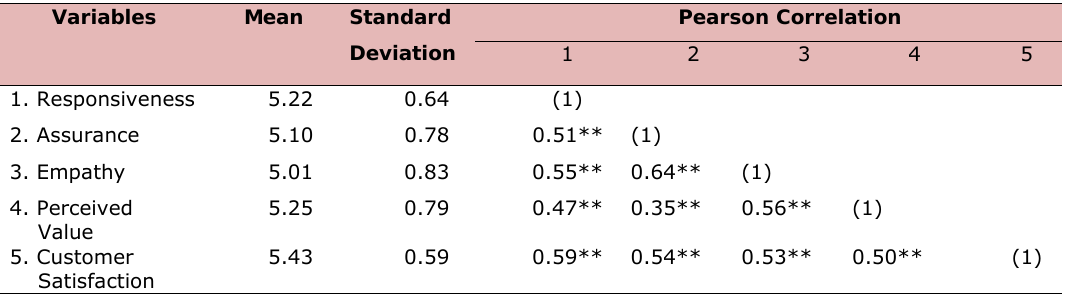
Table 5. “Pearson correlation coefficients between variables and descriptive